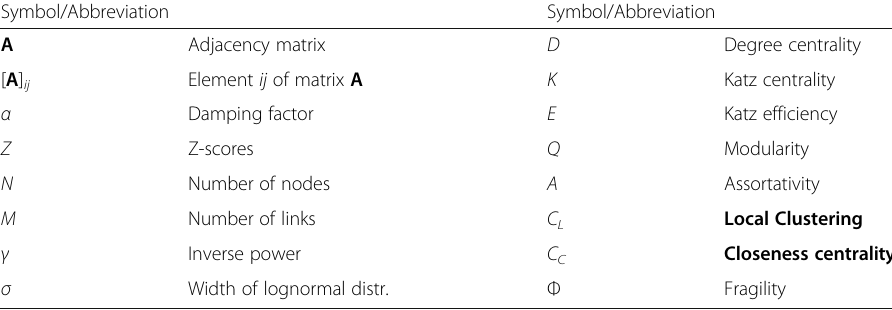
Table 1 Summary of symbols and abbreviations used recurrently in the text and